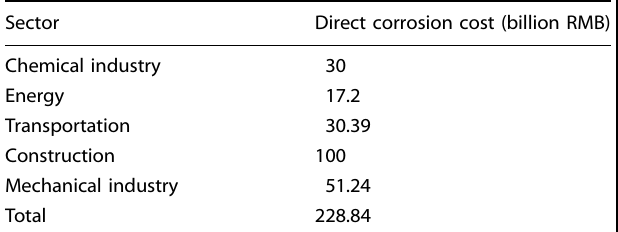
Table 4. The cost of corrosion in the 2002 national survey in China (Hoar method)